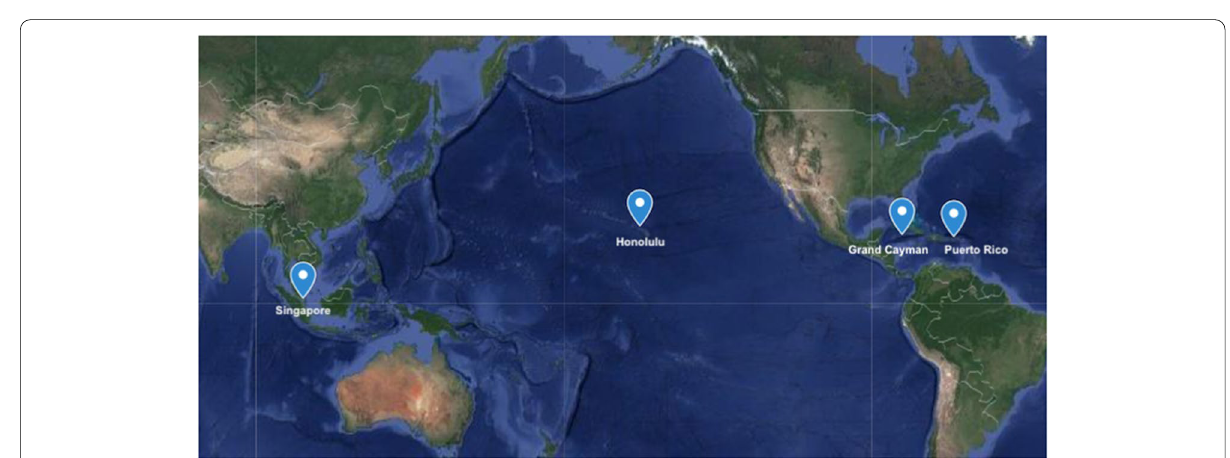
Fig. 1 Islands performing/developing LVAD